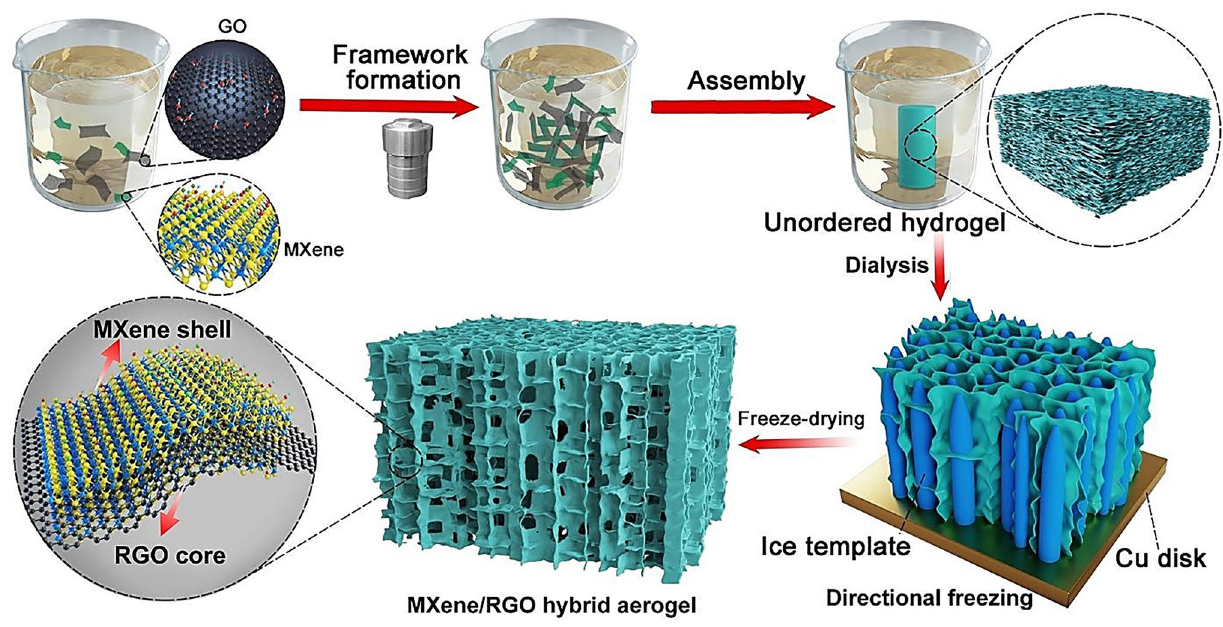
Fig. 2 The preparative process of MXene-reduced graphene oxide (RGO) hybrid aerogels through GO-assisted hydrothermal assembly tech- nique followed by directional-freezing and freeze-drying processes. Reproduced with permission from Ref. [24]. Copyright 2018 American Chemical